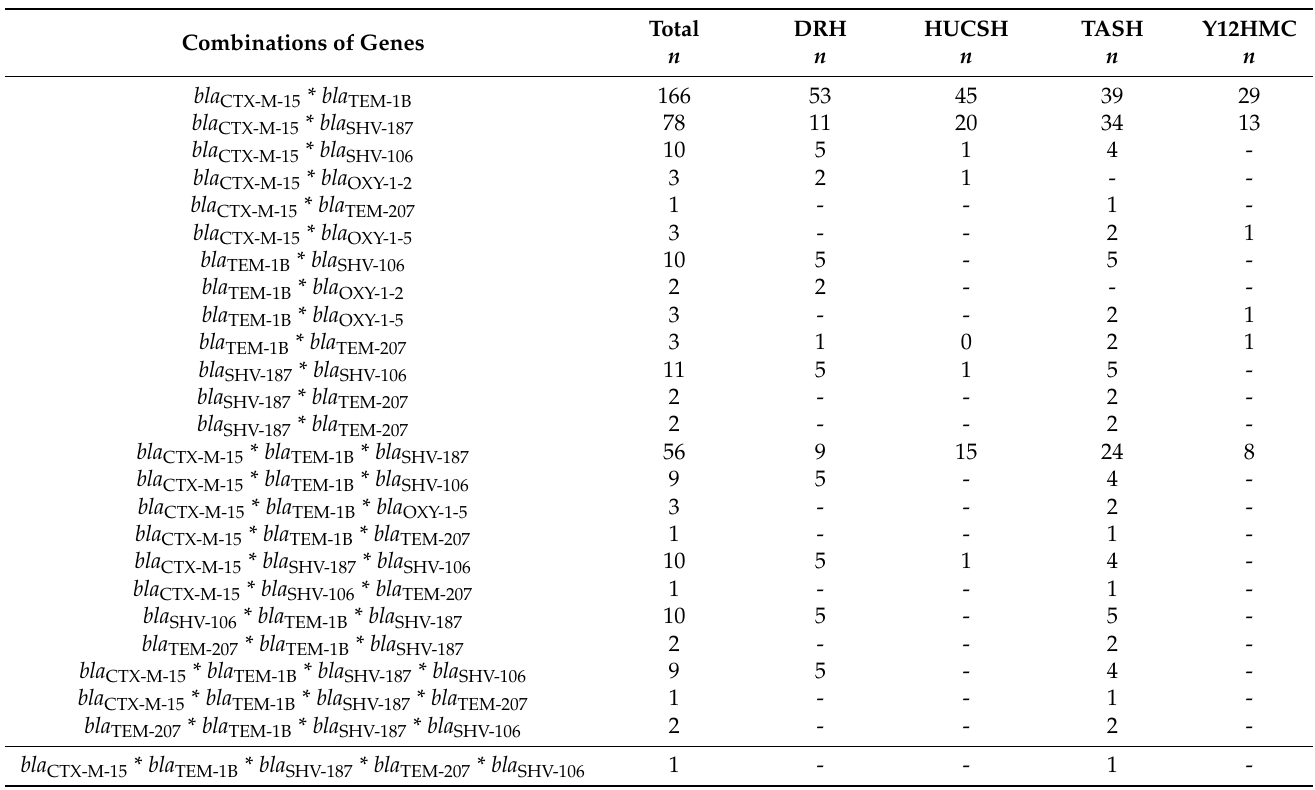
Table 6. Co-occurrence of multiple ESBL genes and ESBL genes with other common non-ESBL variants of bla TEM and bla SHV